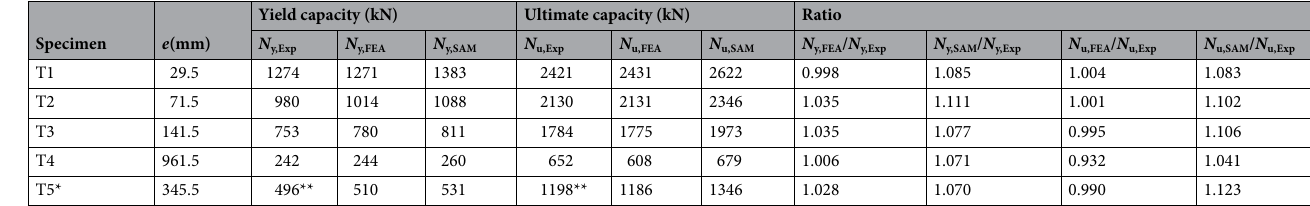
Table 4. Capacities of specimens. *Specimen in Ref. 15 , possessing geometrical dimensions identical to the specimens in this study. **Experimental data from Ref 15